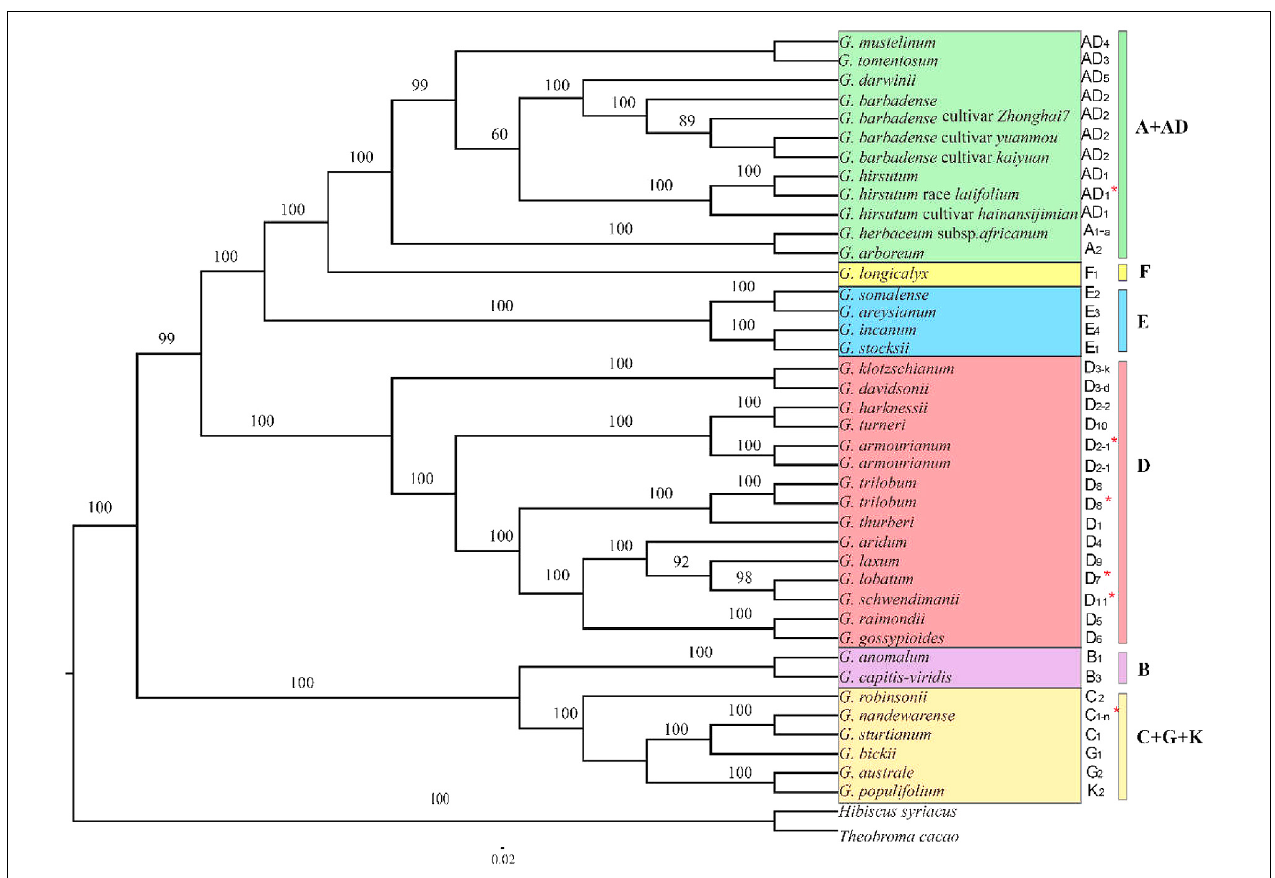
FIGURE 6 | Phylogenetic relationships among the 40 Gossypium species based on complete chloroplast genome sequences. Different colors represent six genetic clades and red asterisks indicate the newly sequenced species. Hibiscus syriacus and Theobroma cacao were used as